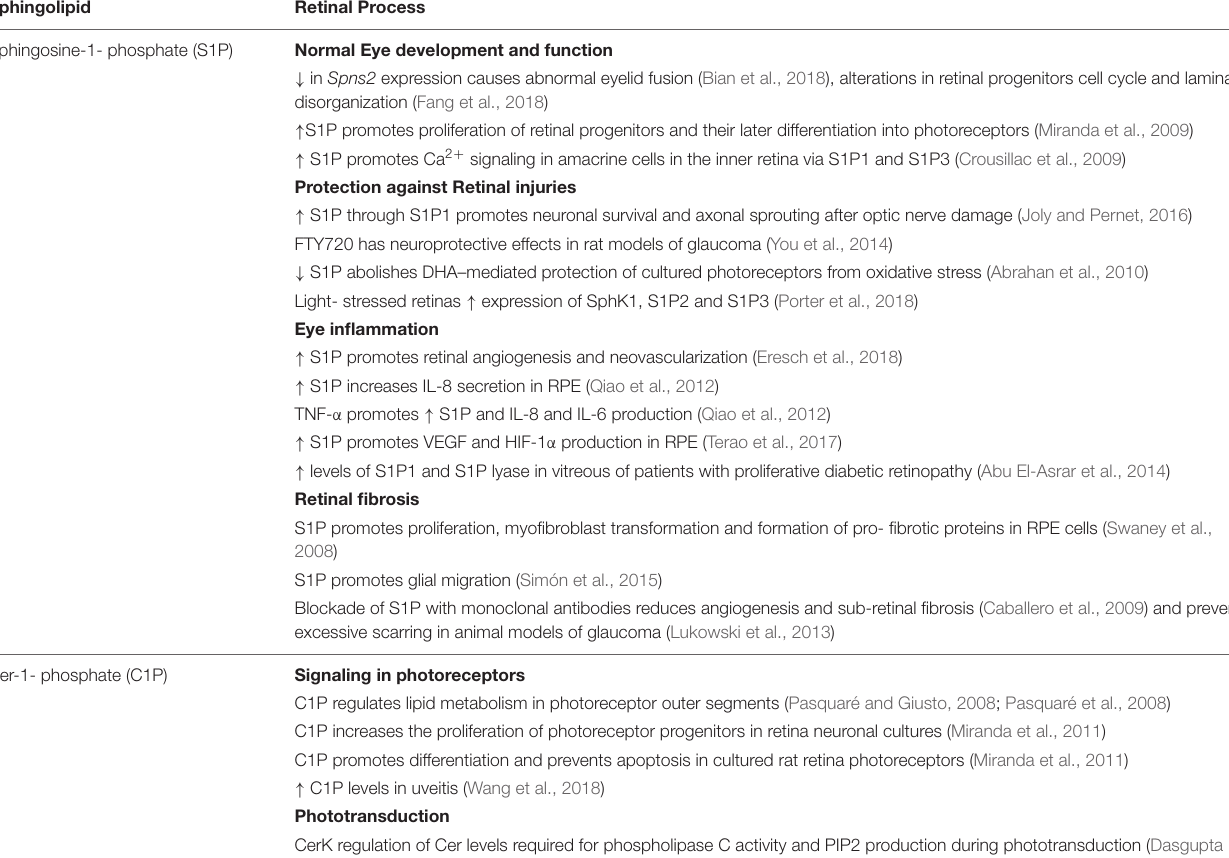
TABLE 2 | Functions of Sphingosine-1-phosphate and Ceramide-1-phosphate in the retina. Sphingolipid Retinal Process Sphingosine-1- phosphate